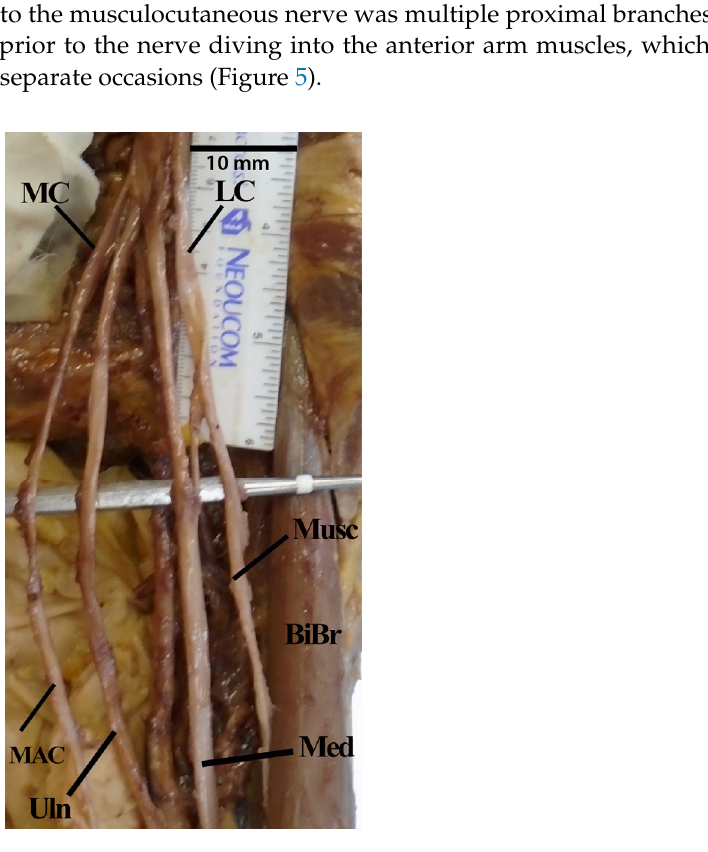
Figure 4. Photograph of musculocutaneous nerve piercing biceps brachii rather than coracobrachialis. Abbreviations: BiBr = biceps brachii muscle; LC = lateral cord; MAC = medial antebrachial cutaneous nerve MC = medial cord; Med = median nerve; Musc = musculocutaneous nerve; Uln = ulnar nerve.